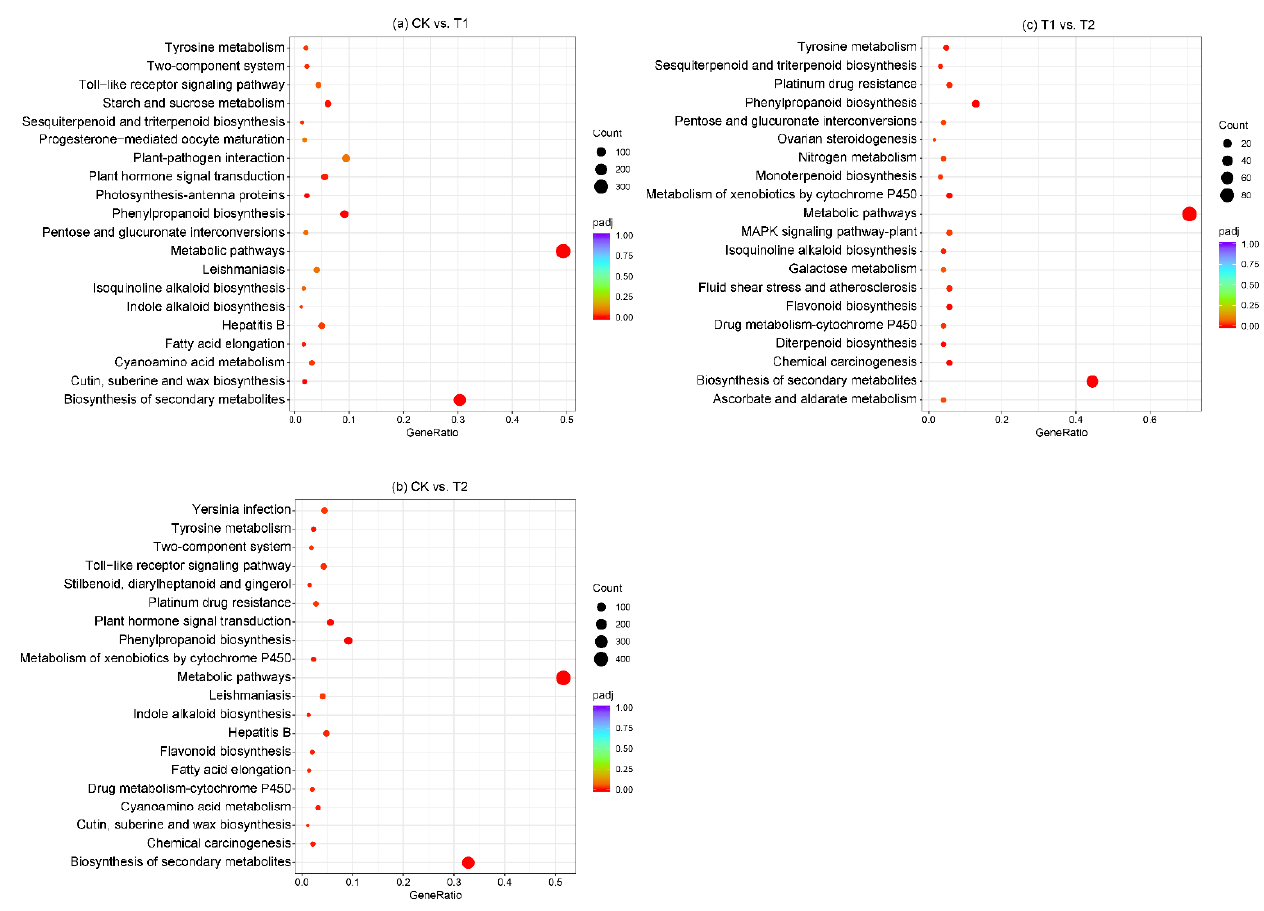
Figure 5. The scattering map of KEGG enrichment of differentially expressed genes in Michelia macclurei . The vertical axis indicates the pathway name, and the horizontal axis represents the gene ratio of the corresponding pathway. The Q-value was shown by the color; the smaller the Q-value, the closer the color is to red. The point size represents the number of DEGs. ( a – c ) represents the three comparisons of CK vs. T1, CK vs. T2, and T1 vs. T2.